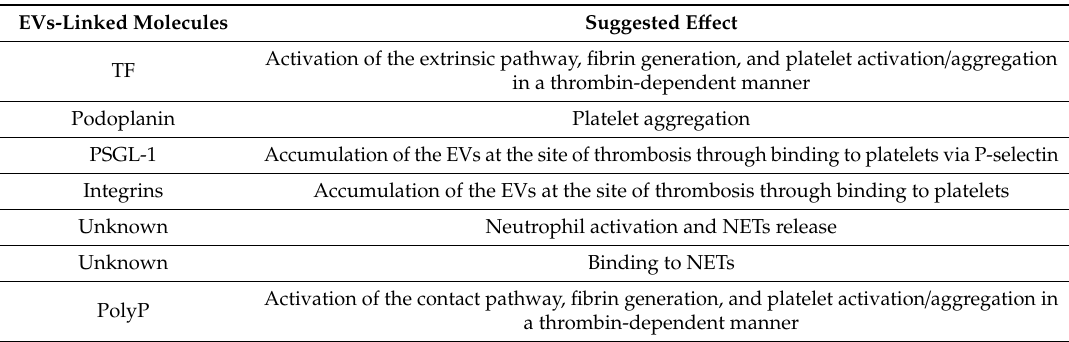
Table 2. EVs-derived molecules and their possible prothrombotic